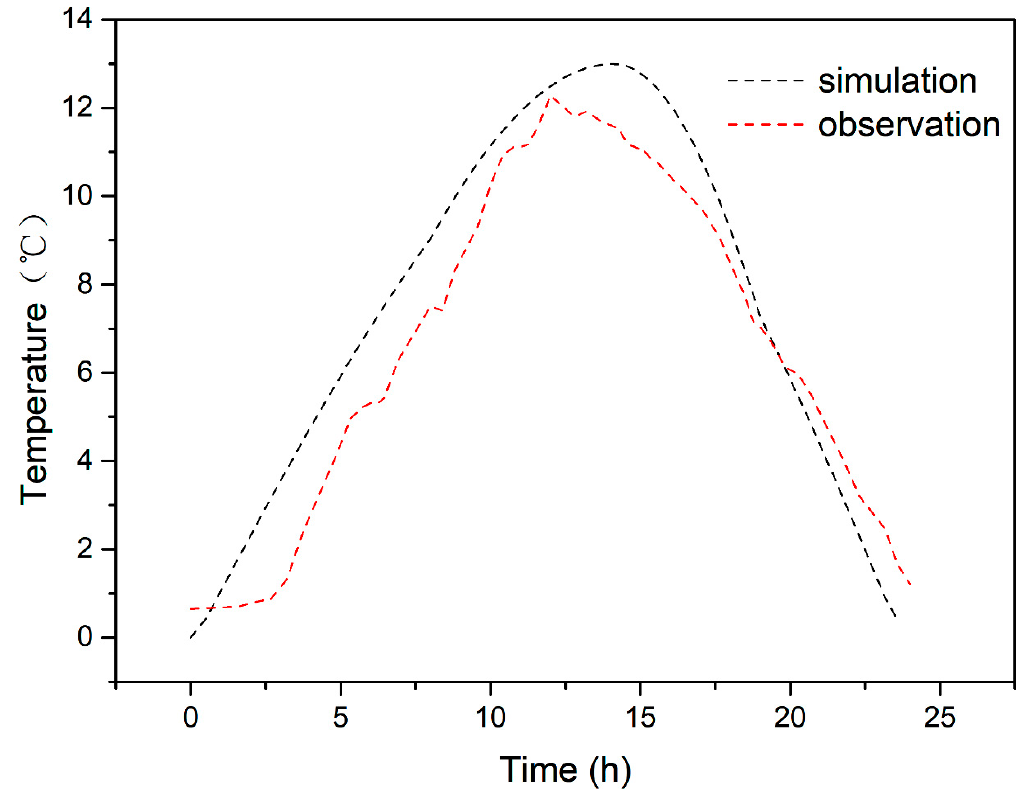
Figure 3. Daily actual temperature change and simulation curve.